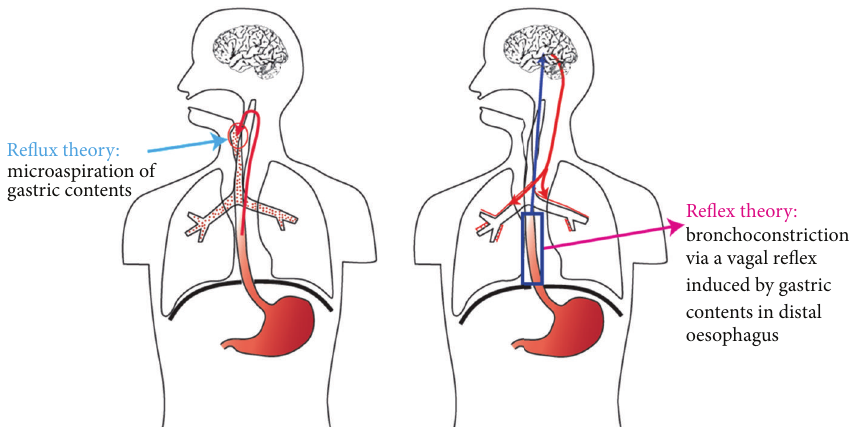
Figure 1: Two theories exist on how gastroesophageal reflux induces respiratory symptoms, called the reflux and reflex theories.